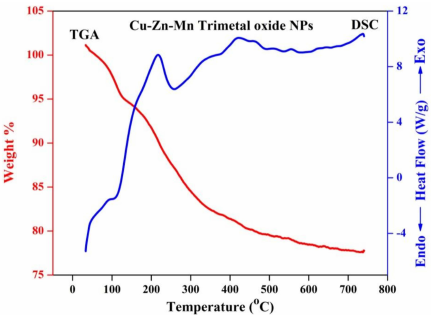
Figure 10. TG-DSC of Cu-Zn-Mn mixed trimetal oxide nanoparticles.